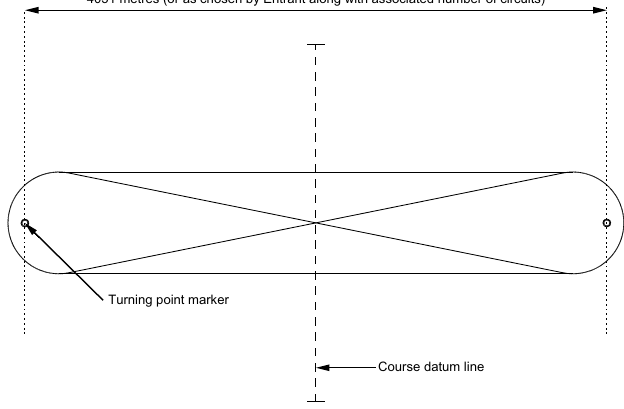
Figure 2. The Kremer International Marathon